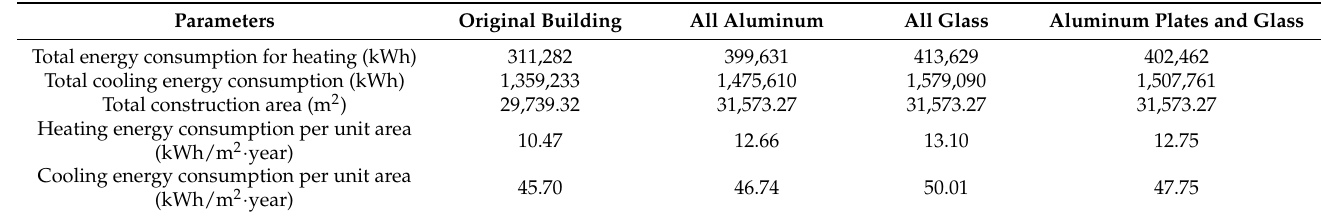
Table 5. Building energy simulation